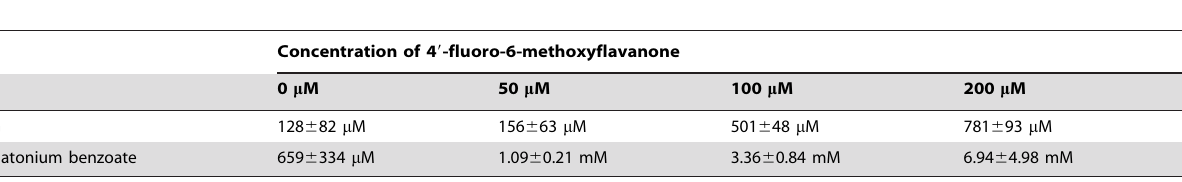
Table 4. EC 50 values of ECG and denatonium benzoate in the presence of various concentrations of 4 9 -fluoro-6-methoxyflavanone ( 6 ) on